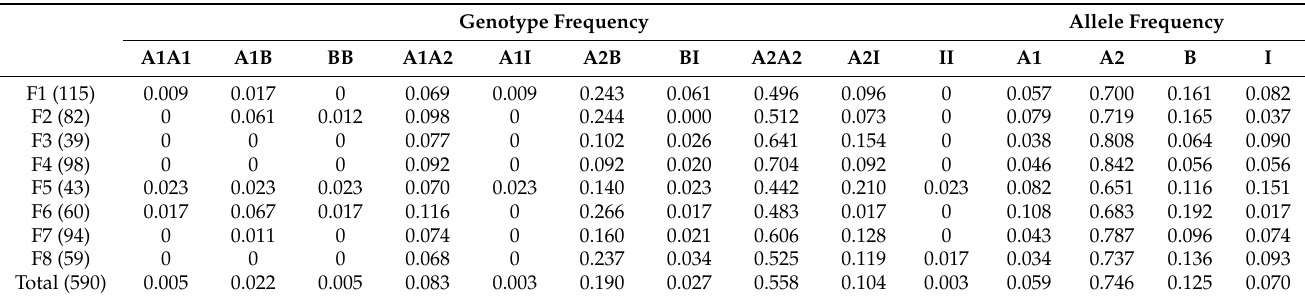
Table 3. Genotype and allele frequencies of β -casein genes in Jersey herds in Okayama Prefecture, western Japan. Genotype